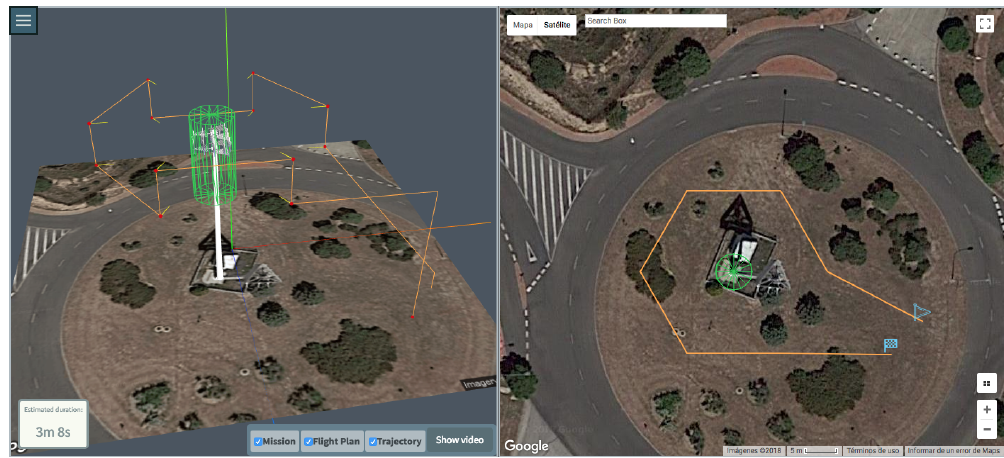
Figure 14. Mission of the inspection of a telecommunication